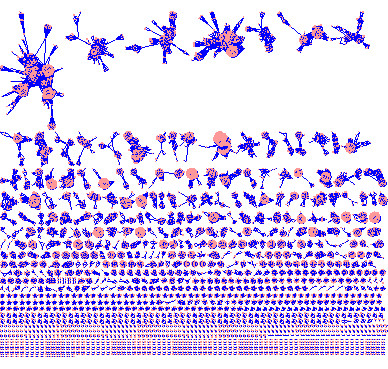
The HMM network.